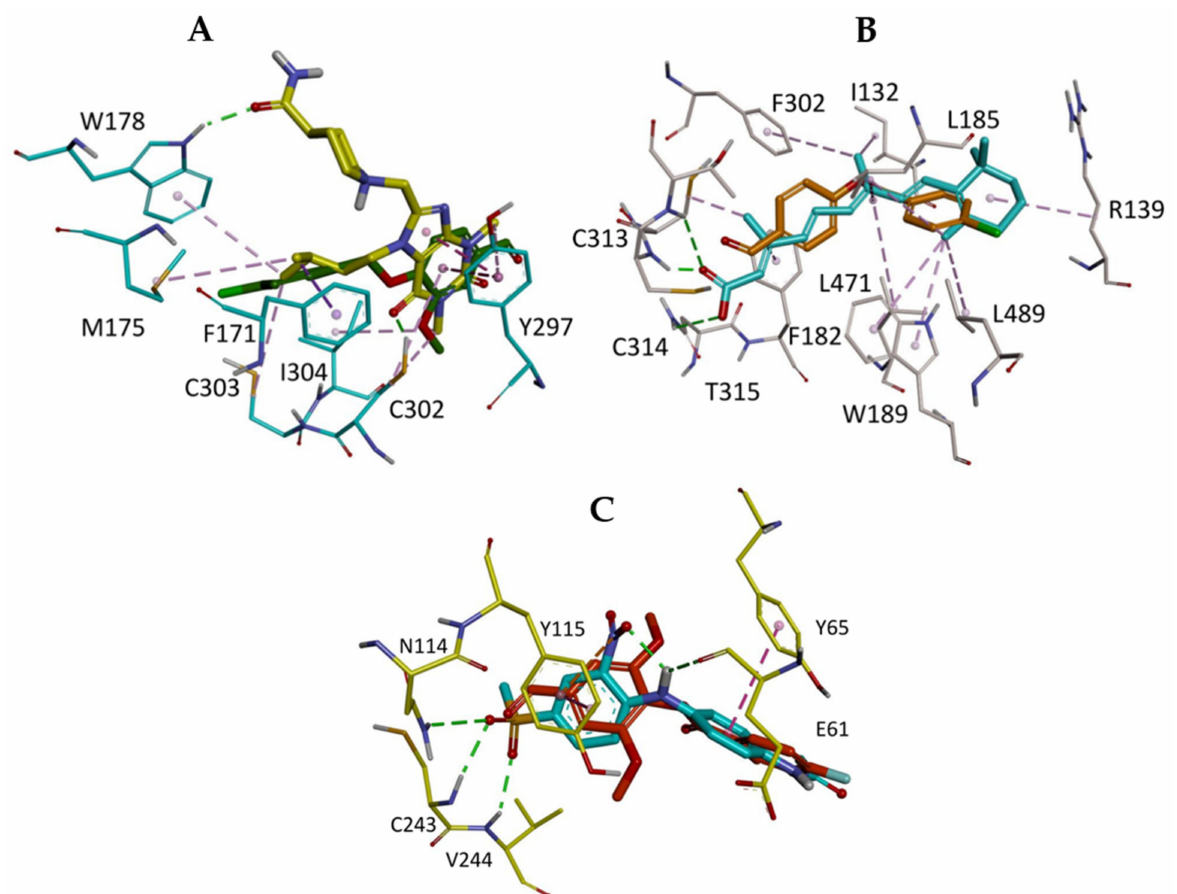
Figure 7. Superimposition of ( A ) co-crystallized inhibitor (green) of ALDH1A1 (cyan residues) and ABMM-16 (yellow), ( B ) substrate (RA, green) of ALDH1A3 (gray residues) and ABMM-15 (orange) and ( C ) co-crystallized inhibitor (cyan) of ALDH3A1 (yellow residues) and ABMM-18 (Red). Only the interactions of co-crystallized inhibitors/substrate are shown for